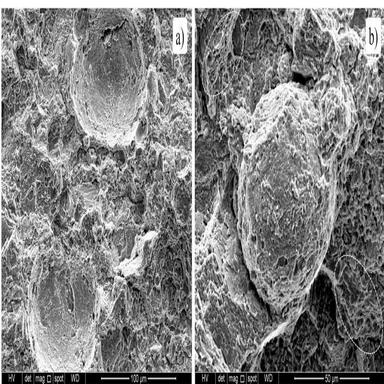
Fractographs of stress rupture tested samples at a) lower magnification and b) higher magnification highlighted with dimples.